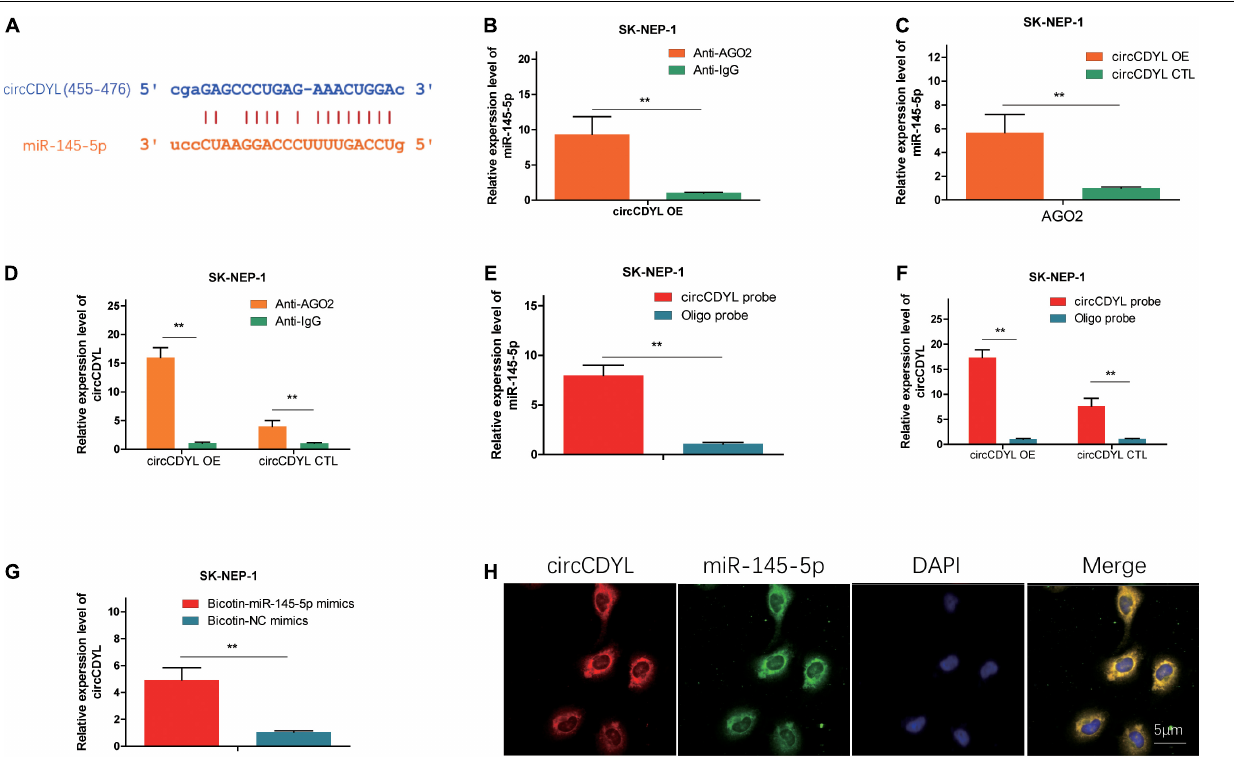
FIGURE 3 | CircCDYL acts as a molecular sponge for miR-145-5p. (A) Possible binding sites between circCDYL and miR-145-5p. (B) The amount of circCDYL in circCDYL OE or circCDYL CTL groups was detected by an Ago2 RIP assay. (C) The relative enrichment level of miR-145-5p immunoprecipitated by Ago2 in circCDYL OE or CTL groups. (D) The relative enrichment level of miR-145-5p in the circCDYL OE group immunoprecipitated by Ago2 or IgG. (E) The relative enrichment level of miR-145-5p pulled down by biotinylated circCDYL probes or Oligo probes in the circCDYL OE group. (F) The relative enrichment level of circCDYL pulled down by biotinylated circCDYL probes or Oligo probes in the circCDYL OE or circCDYL CTL groups, respectively. (G) The relative enrichment level of circCDYL pulled down by biotinylated miR-145-5p mimics or non-sense control (NC) mimics in the circCDYL OE group. (H) circCDYL and miR-145-5p in G401 cells were colocalized by FISH. circCDYL was stained red, miR-145-5p was stained green, and the nuclei were stained blue (DAPI). Data represent the mean ± SD from three independent experiments. Student’s t -test with two biologically dependent or independent replicates was used to determine statistical significance; *** P < 0.001, ** P < 0.01, * P < 0.05.